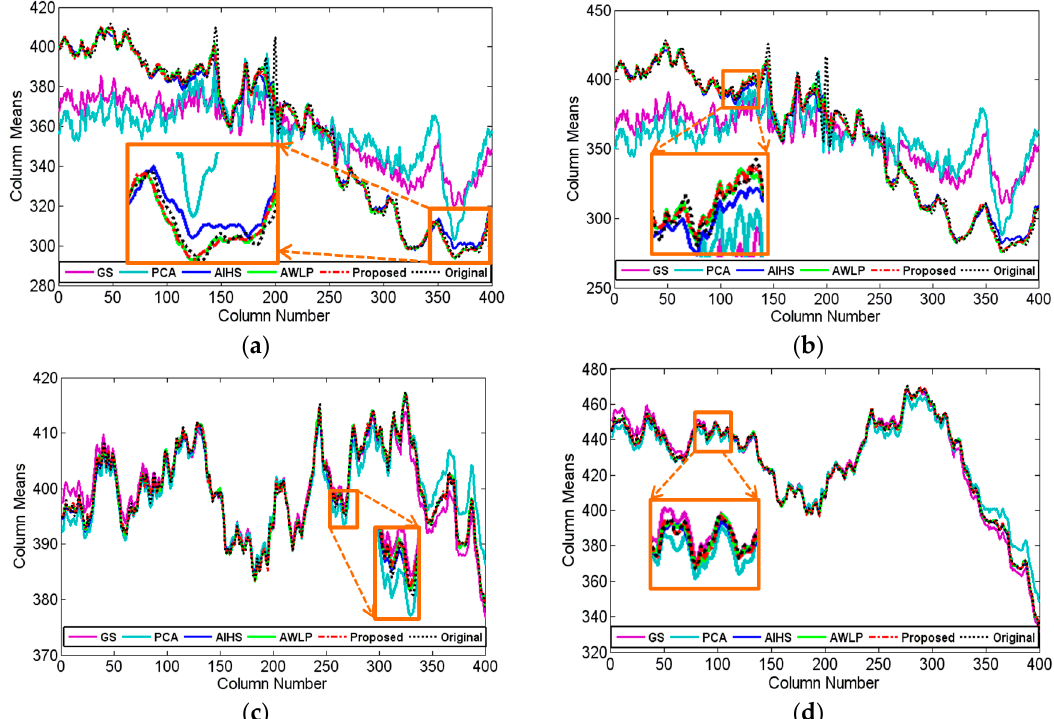
Figure 8. Horizontal profiles of the column means for the GF-1 fusion results by the different fusion methods. ( a ) band 1; ( b ) band 2; ( c ) band 3; ( d ) band 4.